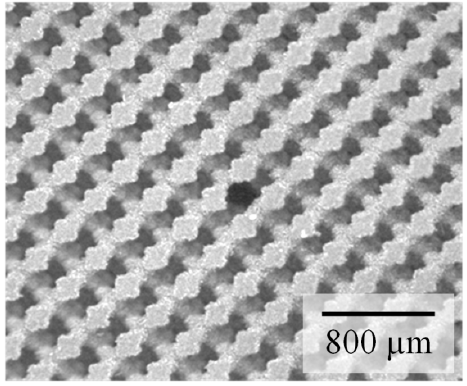
Figure 8. The magnetophotonic crystal with a structural defect in the periodic lattice of the diamond structure. The round hole was opened as the defect cavity for the perpendicularly direction toward the crystal face.